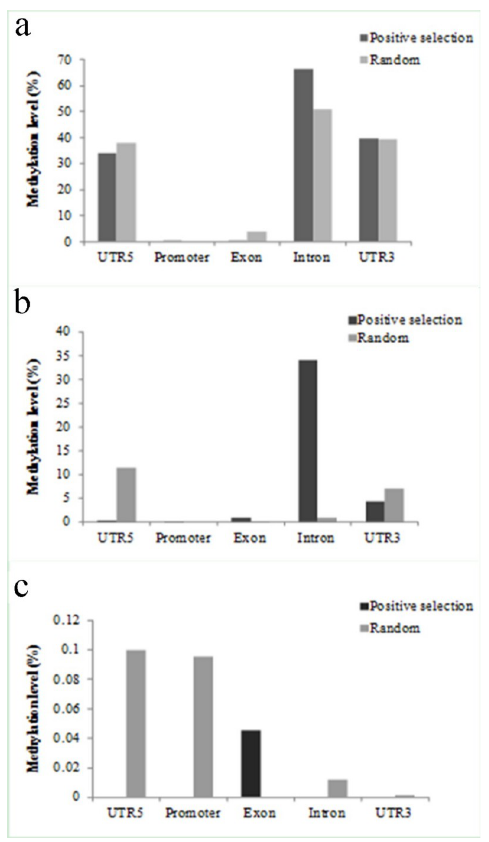
Fig 7. Comparisons of DNA methylation level between positively selected and randomly selected genes in different regions at CG (a), CHG (b) and CHH (c) contexts.